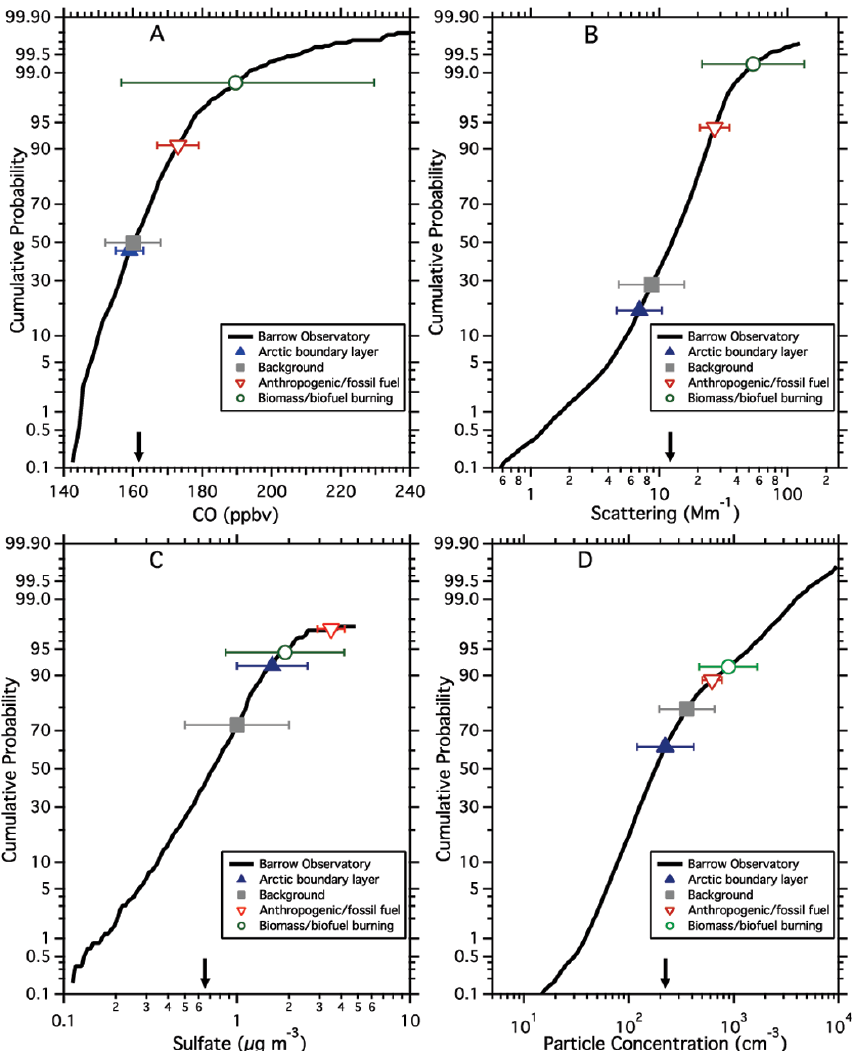
Fig. 12. (A) Cumulative probability distribution of CO measured at the NOAA Baseline Observatory in Barrow, Alaska (Novelli et al., 2008). Data are hourly measurements from February–April over the period 2005–2008. Arrow indicates arithmetic mean value. Data have not been filtered for possible contamination from local sources. Symbols and error bars are the geometric mean and standard deviation for the four airmass classifications (see legend) measured on the NOAA WP-3D during ARCPAC and are positioned vertically on the Barrow cumulative probability distributions. (B) As for (A) , but for sub-1µm light scattering at 550nm measured at Barrow from 1987–2008 (line) and sub-1µm extinction at 532nm from the WP-3D during ARCPAC (symbols). Arrow indicates geometric mean value from Barrow. Barrow aerosol data have been filtered for possible contamination from local sources (Delene and Ogren, 2002). (C) As for (B) , but for sub-1µm sulfate measured by the University of Washington over approximately 2-day periods at Barrow from 1997–2008 (line) and sub-1µm sulfate measured on the NOAA WP-3D during ARCPAC (symbols). (D) As for (B) , but for total particle concentrations measured at Barrow (line) and aboard the NOAA WP-3D aircraft